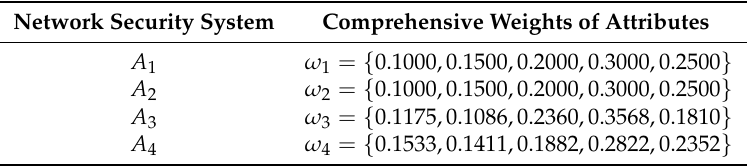
Table 16. The comprehensive weights of the attributes of A i